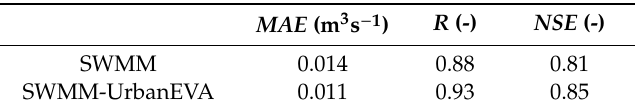
Table 8. Model performance based on error measures and performance criteria related to the base flow rate in the period 21 January 2016 to 31 July